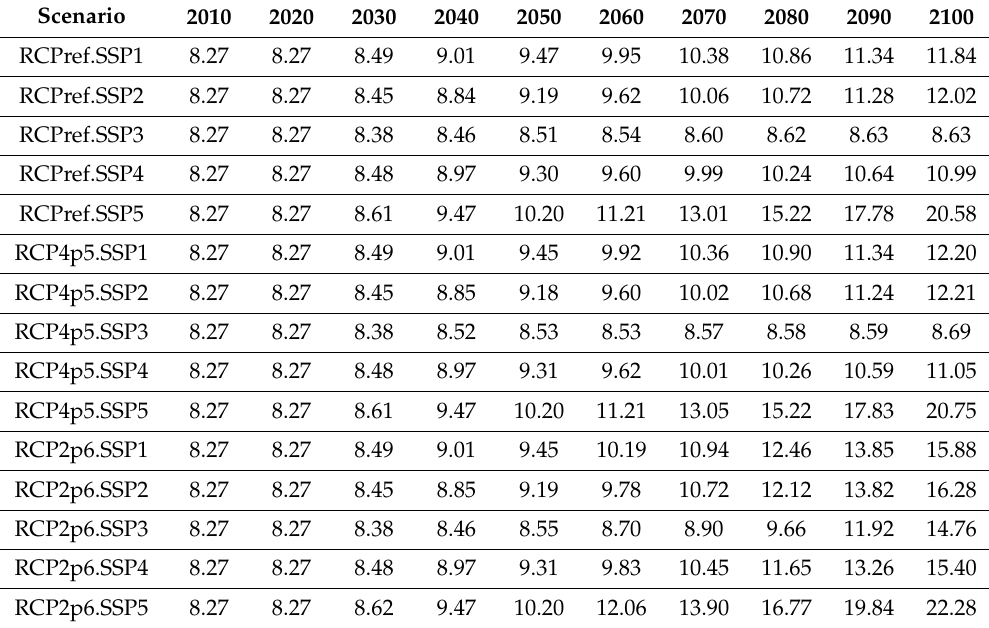
Table A21. Industrial roundwood harvest (millions of m 3 / year, under bark).